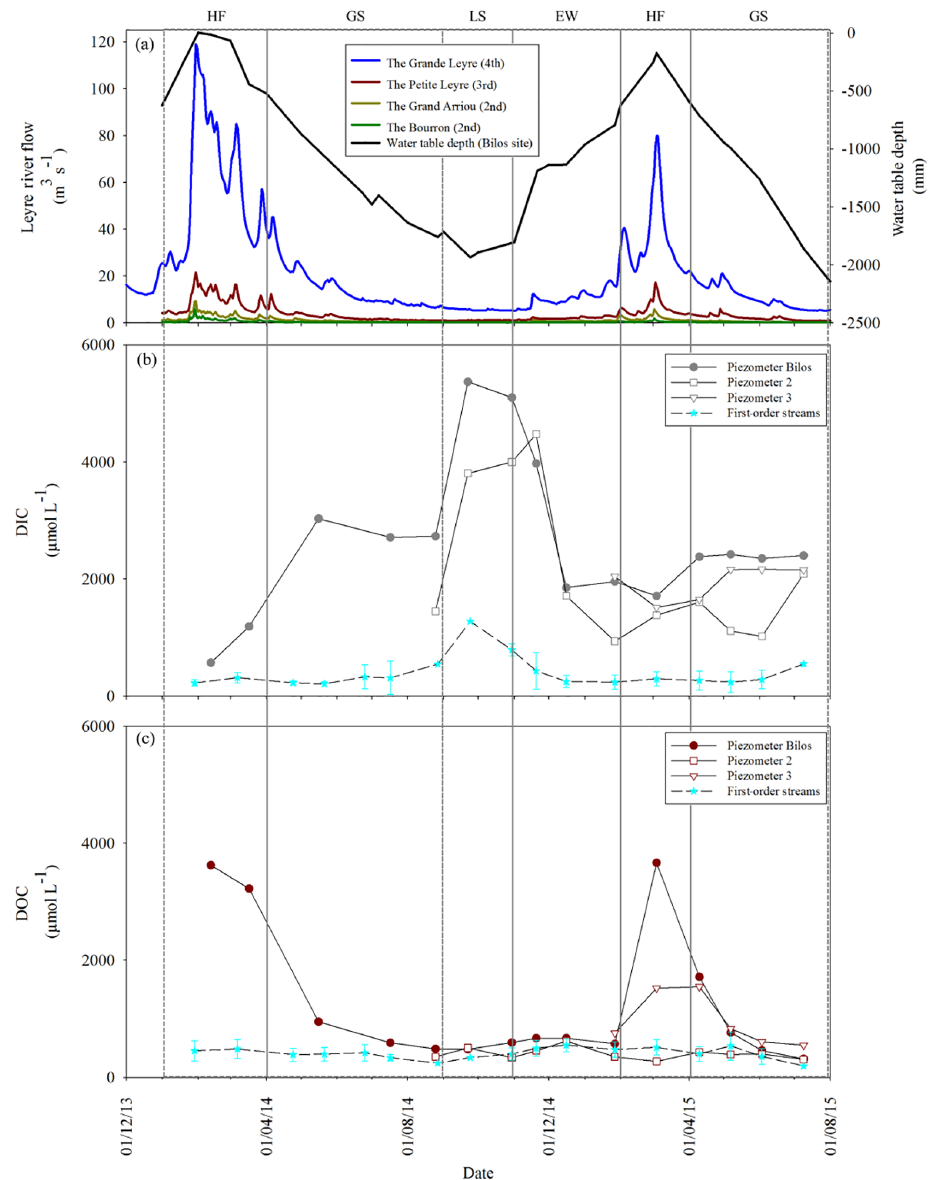
Figure 5. (a) Discharge of the Grande Leyre, the Petite Leyre, the Grand Arriou and the Bourron rivers associated with the water table at the Bilos site. Temporal variations throughout the sampling period in (b) the DIC concentrations, in the sampled piezometers, in the sampled first-order streams (medium dashed line; errors bars represent standard deviation of the six first-order streams), and in (c) the DOC concentrations, in the sampled piezometers and in the sampled first-order streams (medium dashed line; errors bars represent standard deviation of the six first-order streams). HF, GS, LS and EW represent high-flow (January–March 2014 and February–March 2015),